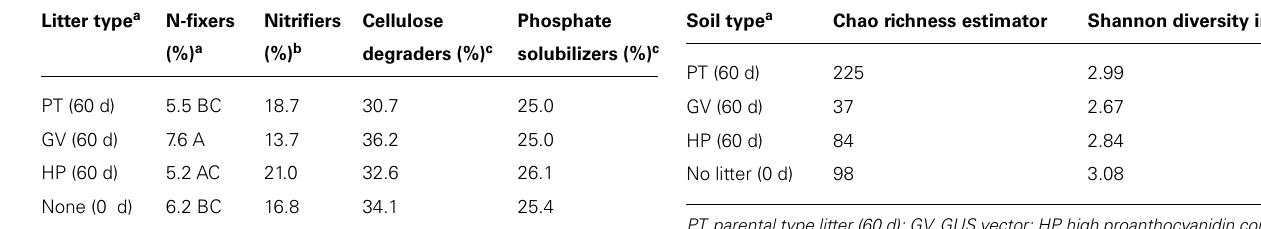
Table 6 |The impact of litter types on the mean proportion of various microbial communities in soil microcosms. Litter type a N-fixers